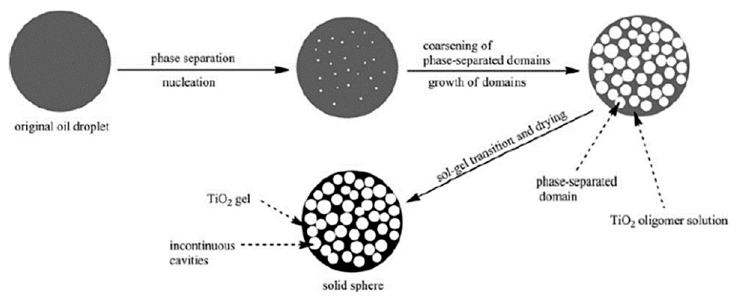
Figure 22. Representation of the mechanism for the formation of TiO 2 microspheres with incontin- uous inner macroporosity. Reprinted from Chinese Chem. Lett., Vol. 25, W. W. Cai, H. Yang, X. Z.